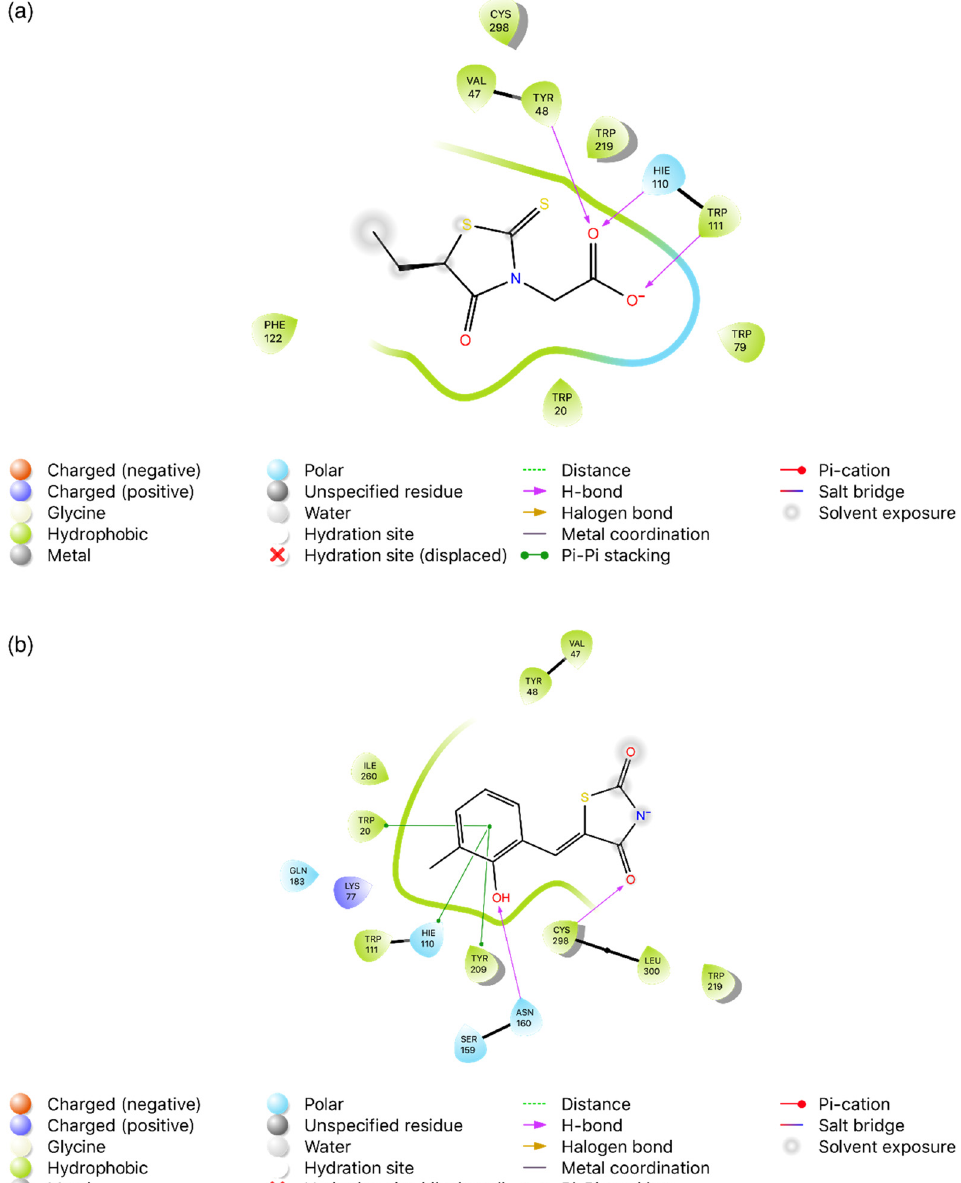
Figure 3: Interactions of the ligands with the key amino acids within the binding site of AR ( PDB ID: 4JIR, 2.00 Å ) . ( a ) 2D ligand interaction diagram of 4JIR with native ligand EPR ( epalrestat ) . ( b ) 2D ligand interaction diagram of 4JIR with compound 3